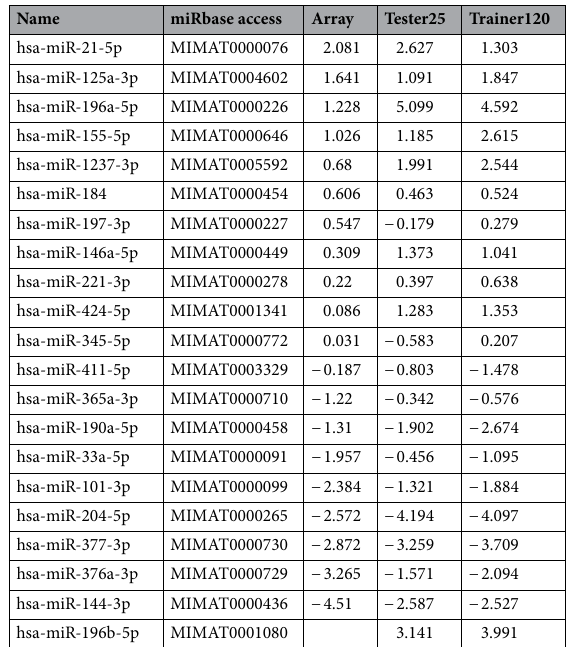
Table 2. Validation table. Showing Log 2 Fold change values of significant mRNAs across both platforms— Array (miRNA microarray) and Real-Time PCR (tester 25 and trainer